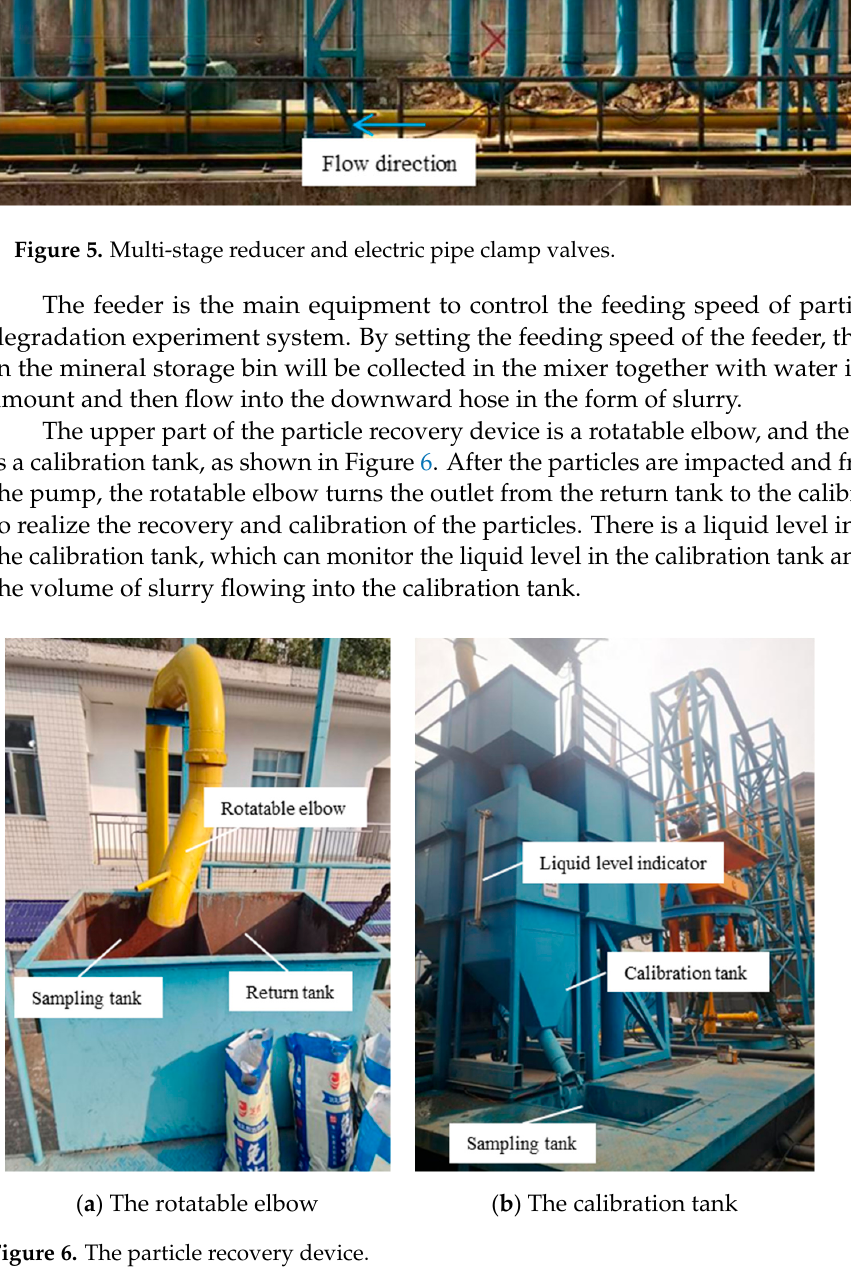
Figure 6. The particle recovery device.